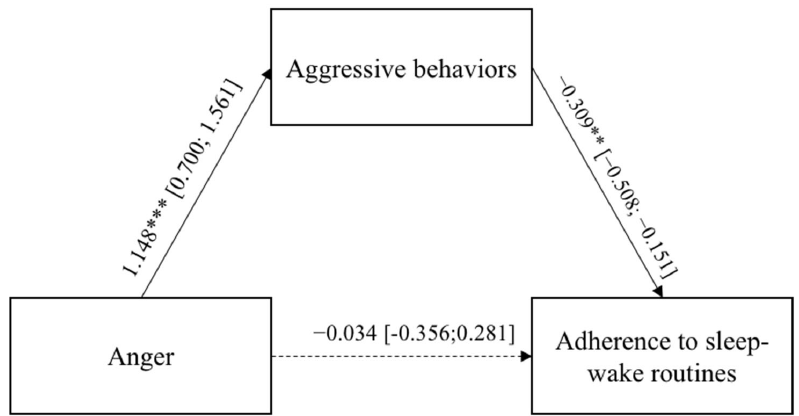
Figure 4. Results of Model 4. The bootstrap intervals of confidence are reported in brackets. * p < 0.05; ** p < 0.01; *** p < 0.001.